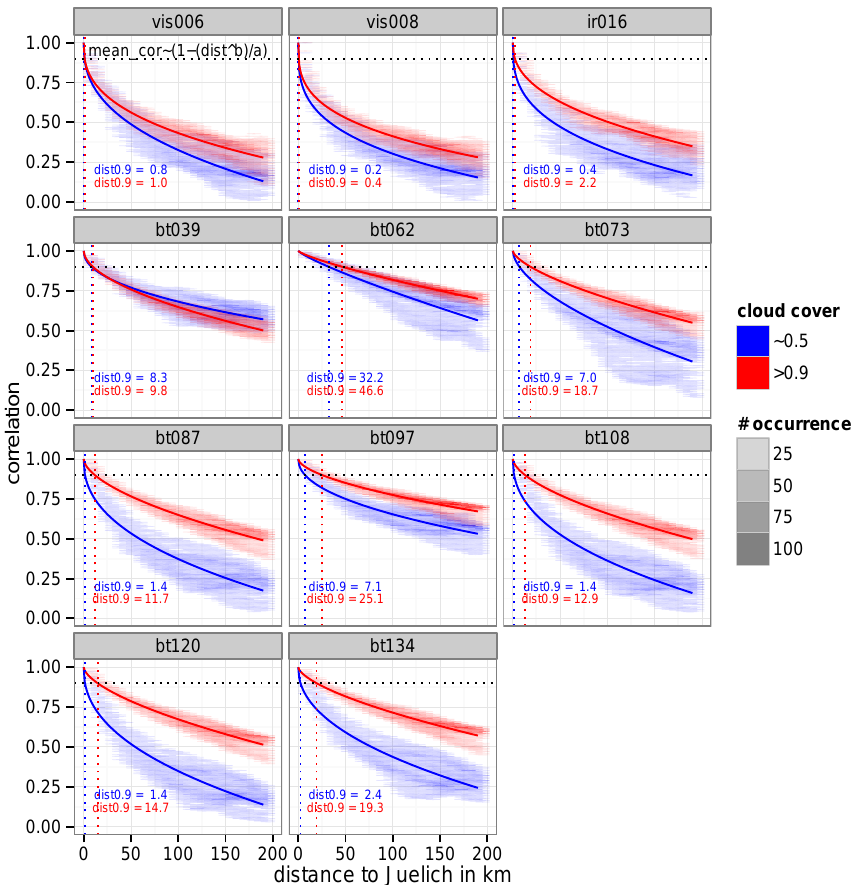
Figure 5. Correlation around Jülich in dependency of the distance for all SEVIRI channels. Red for total and blue for half cloud cover.